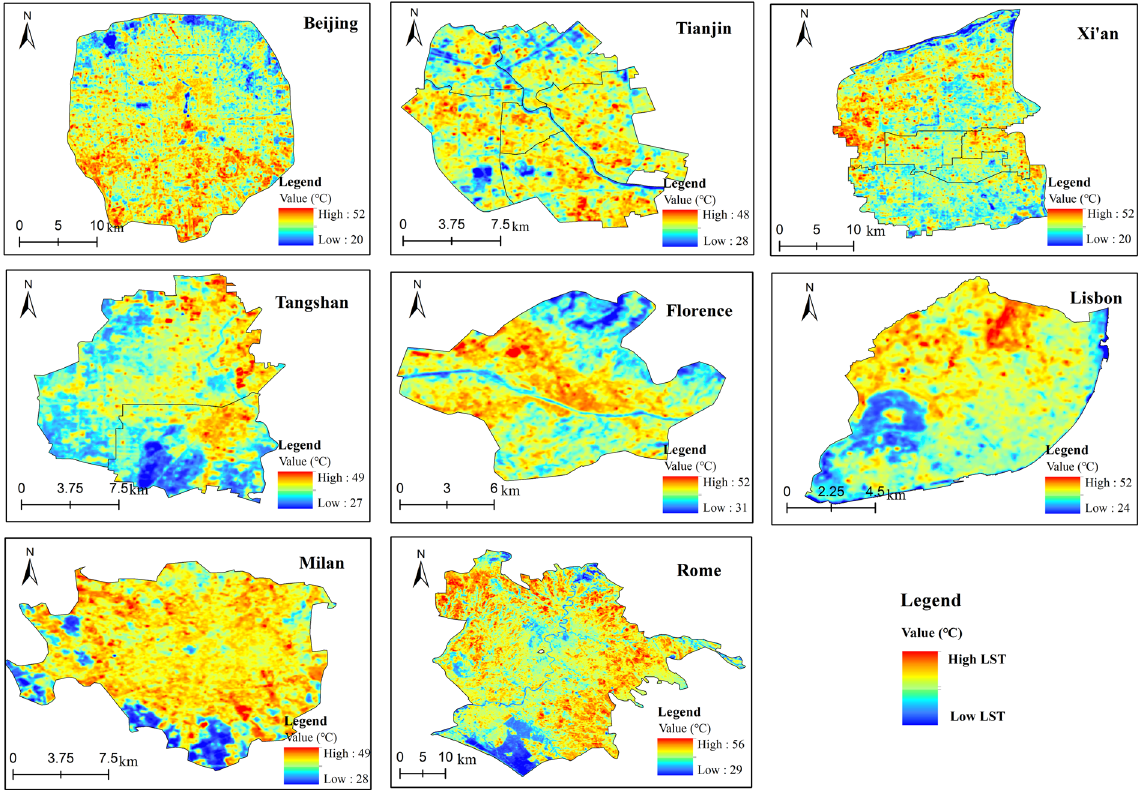
Figure 2. Land surface temperature retrieved by the Radiative Transfer Equation.